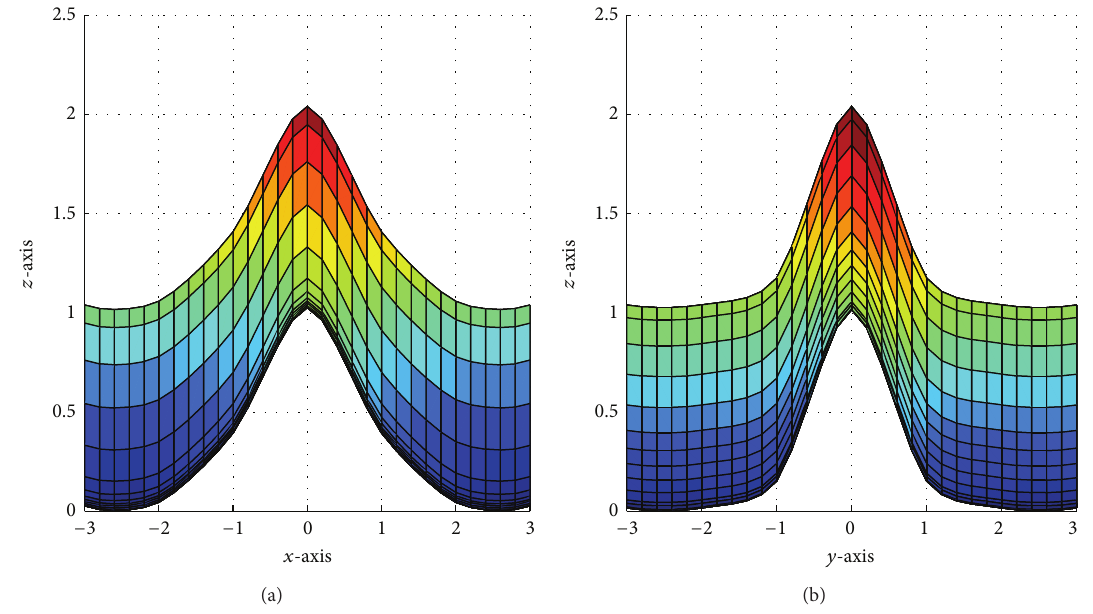
Figure 13: Positivity preserving surface: (a) 𝑥𝑧 -view and (b) 𝑦𝑧 -view for Figure 12, respectively.